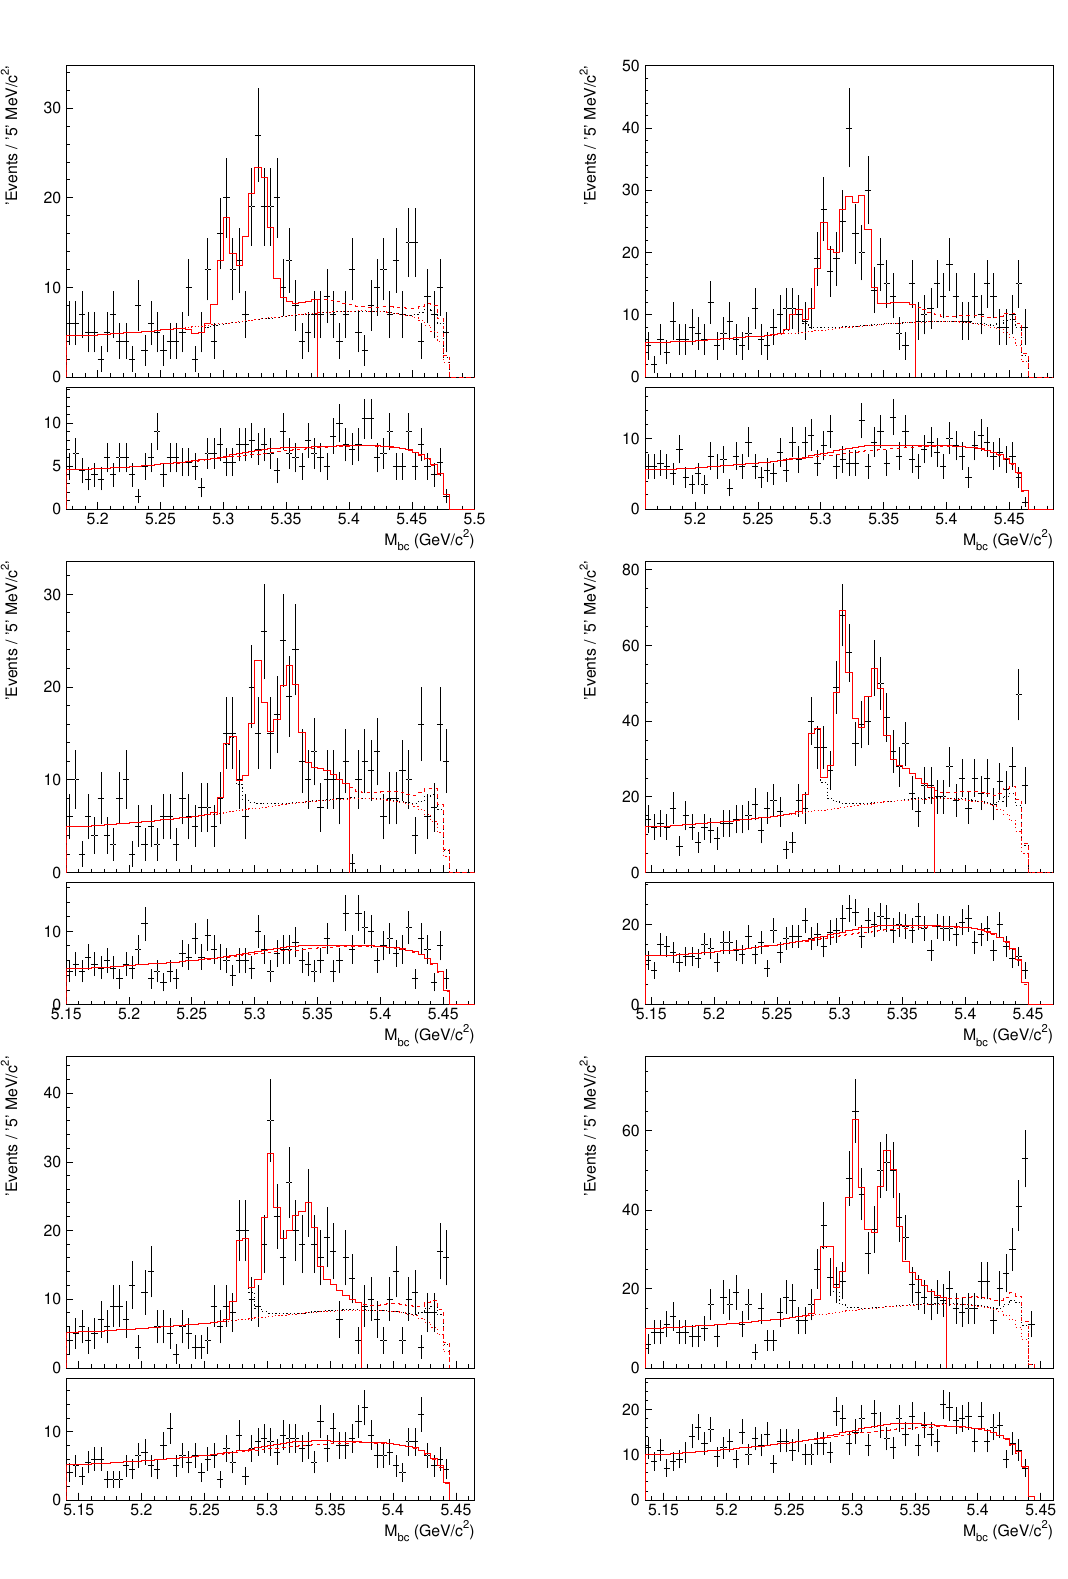
Figure 15 . The M bc distributions for the points 7 to 12 in table 5 (from left to right and from top to bottom). Legend is the same as in figure